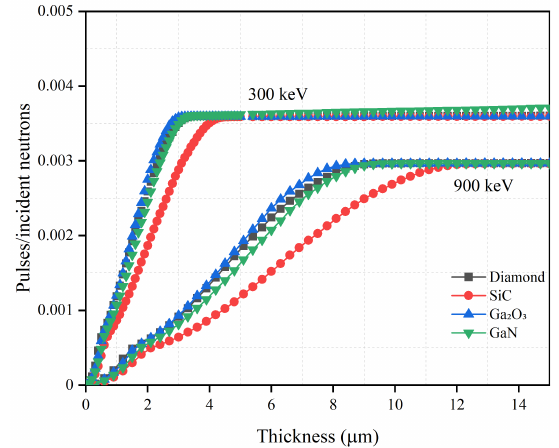
Figure 4. Neutron detection efficiency versus semiconductor material thickness with optimal LiF converter layer thickness for diamond, SiC, Ga 2 O 3 and GaN semiconductor materials. The optimal